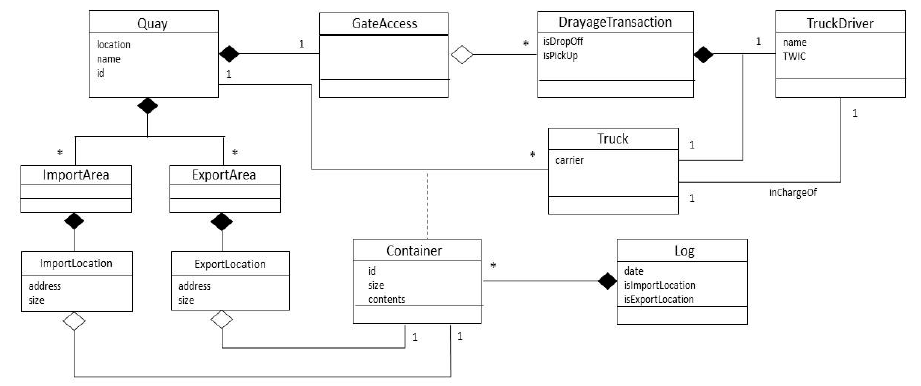
Figure 6. Class Diagram of Cargo Port Drayage.